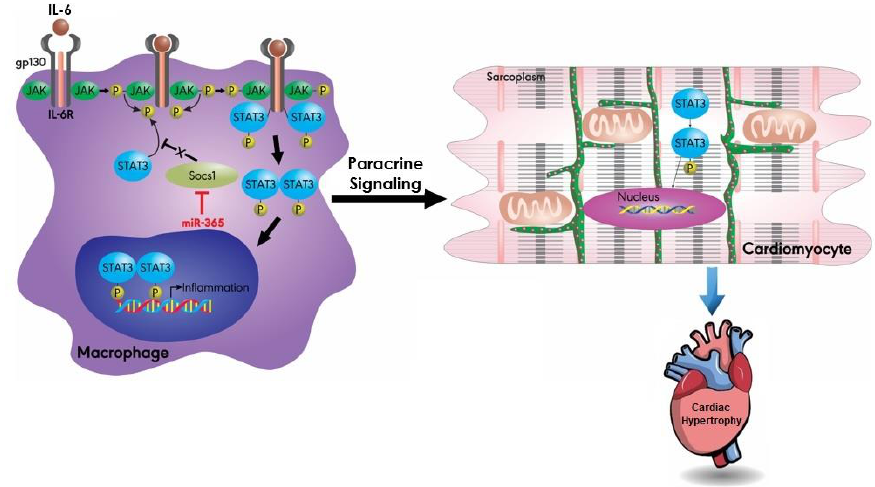
Figure 5. MiR-155 targets the JAK/STAT pathway. The macrophage-expressed miR-155 silences SOCS1 and alleviates its negative regulation of STAT3 phosphorylation. Phosphorylated STAT3 results in inflammation, leading to pro-hypertrophic paracrine signaling to nearby cardiomyocytes. Activation of STAT3 in cardiomyocytes promotes hypertrophy. JAK: Janus kinase; STAT: signal transducer and activator of transcription; IL-6: interleukin 6; IL-6R: interleukin 6 receptor; SOCS1: suppressor of cytokine signaling 1; gp130: glycoprotein